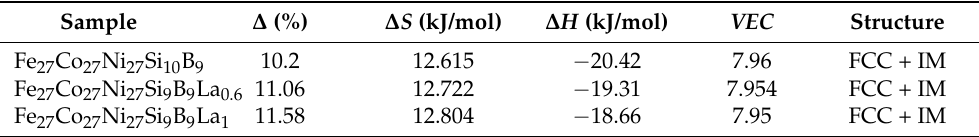
Table 1. The atomic radius difference ( ∆ ), valence electron concentration ( VEC ), mixing enthalpy ( ∆ H mix ), mixing entropy ( ∆ S mix ) and structure of the Fe 27 Co 27 Ni 27 Si 10 − x B 9 La x (x = 0, 0.6, 1) alloy systems (atomic